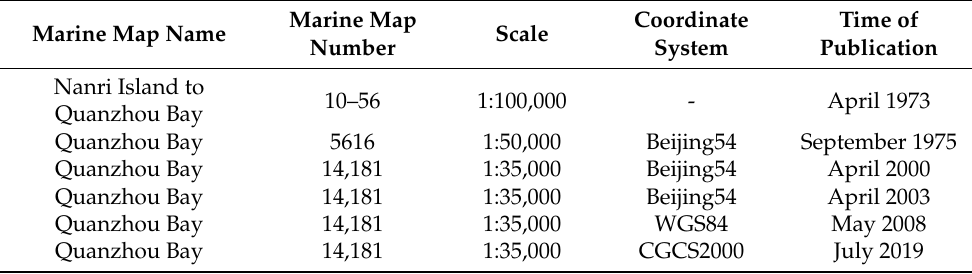
Figure 1. Overview of the study area. ( a ) The location of the study area. ( b ) The basic scenario of the study area, including cities, islands, channels, rivers, and reclamation areas at different stages. ( c ) Tidal currents during the Quanzhou Bay tidal cycle [18]. Table 1. Status of the historical marine map data.